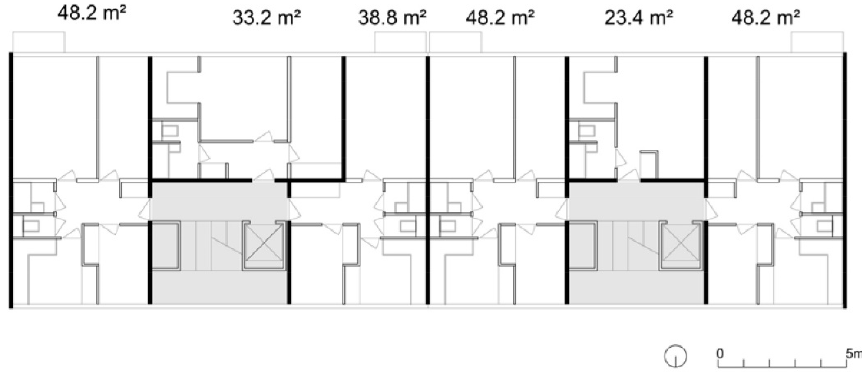
Figure 5. Plan of the exemplary building in the Polish OWT-67 large-panel system with information about the useable area of each apartment. Drawing by the author based on [28].